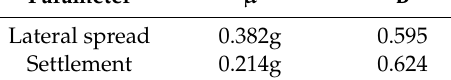
Figure 8. FF: relationships between PGA (g) and ST (m).